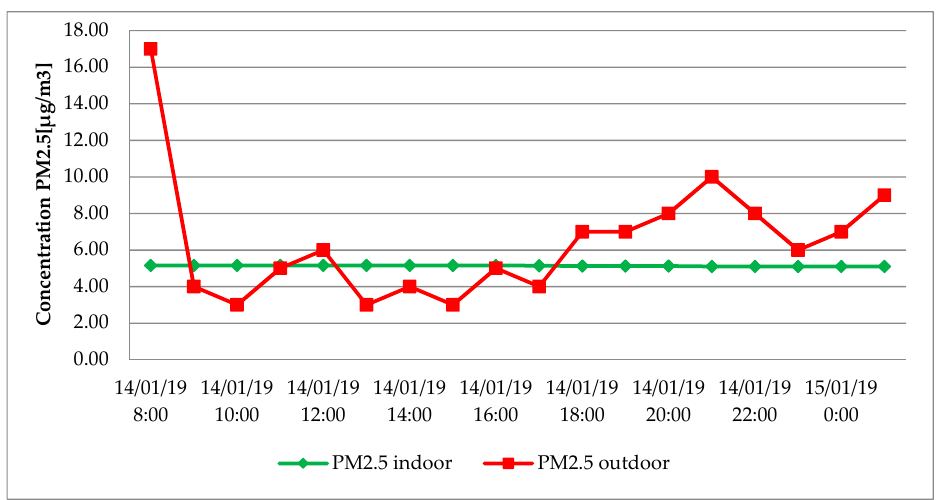
Figure 2. Concentration of PM2.5 (µg/m 3 ) in an apartment in multifamily building (PM2.5 indoor) and in outdoor